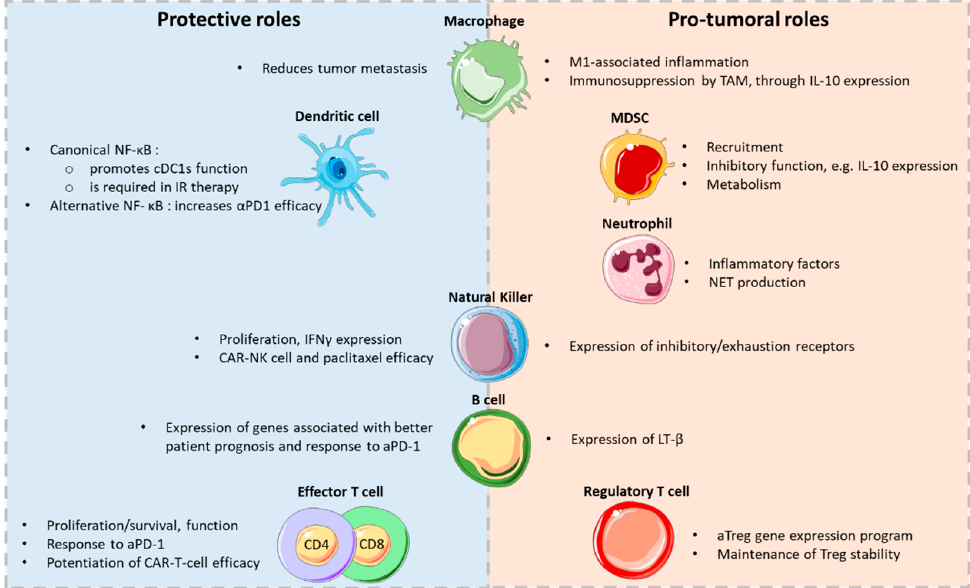
Figure 1. Dual roles of NF-kB in tumor immunity. The figure depicts some of the known functions of NF-kB in immune cell subsets in the tumor environment. Some figure elements were obtained from Servier Medical Art (https://smart.servier.com/).